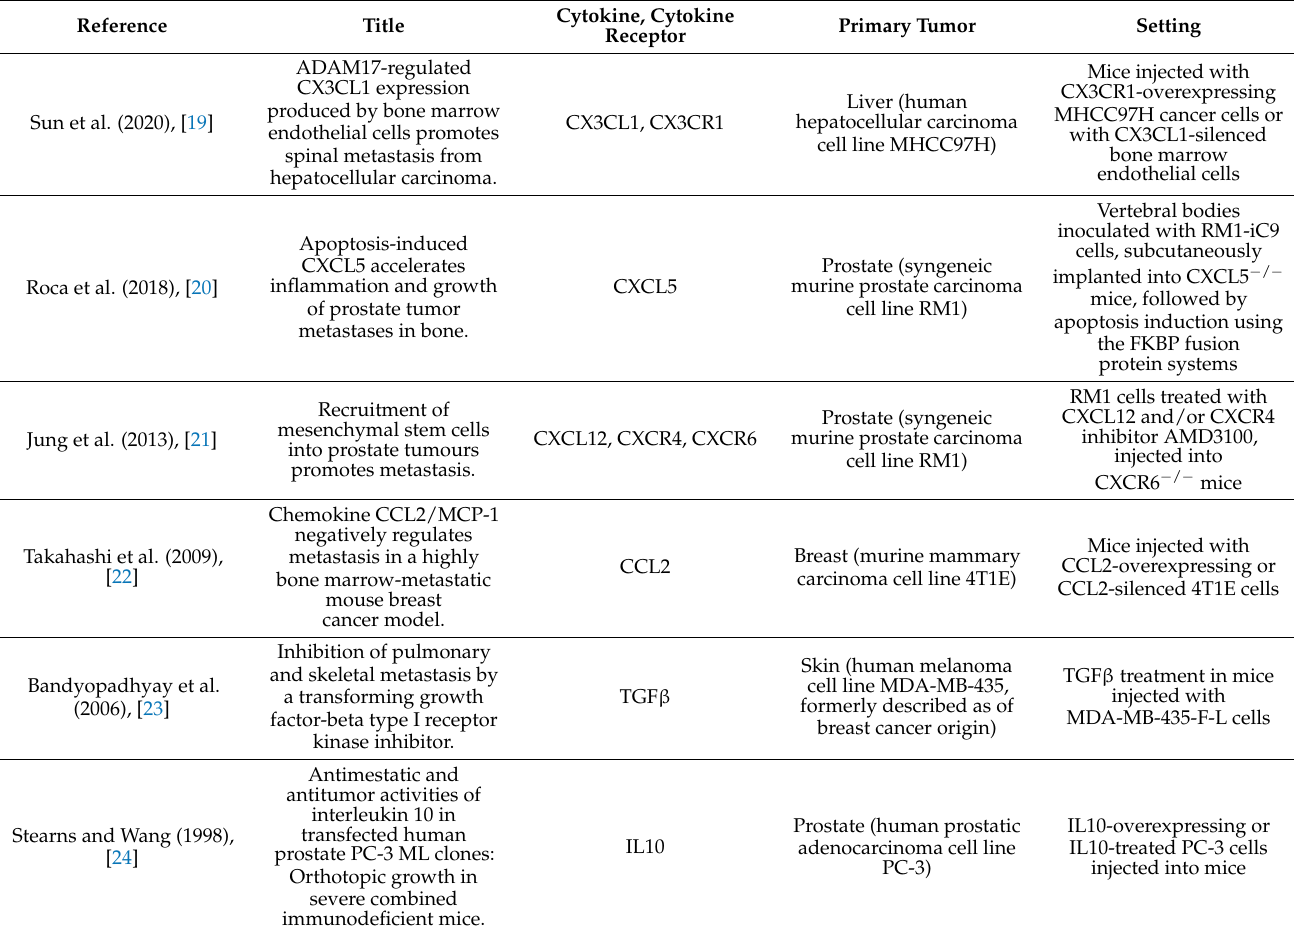
Table 1. List of identified articles demonstrating a functional link between cytokines and spine